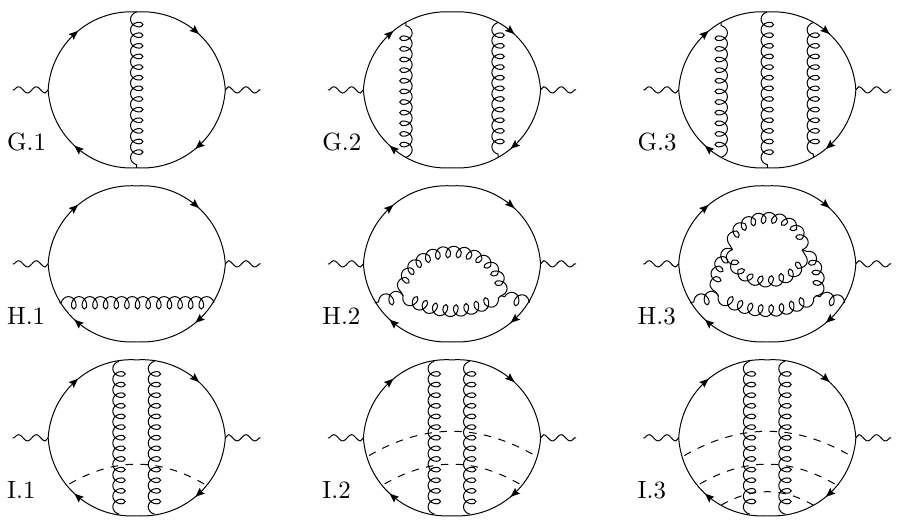
Figure 15. Example supergraphs for increasing N k LO perturbative order, with k = 1 , 2 , 3 for the “double-triangle” class G.x and the “nested self-energy” class H.x. The class of supergraphs I.x corresponds to NNLO contributions to the process γ ? → t ¯ t + N × H where N = 1 , 2 , 3